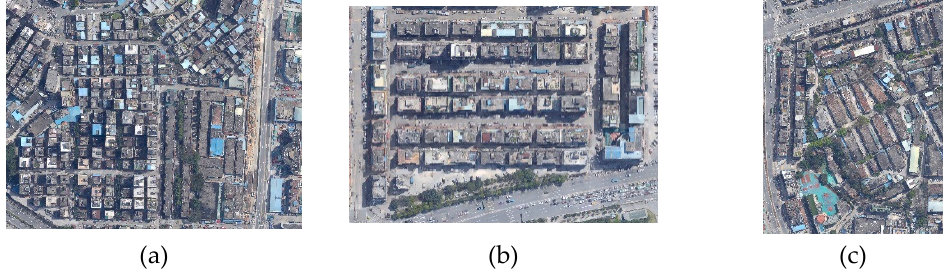
Figure 2. Expermential area of China. ( a ) region 1, ( b ) region 2, and ( c ) region 3 from drone images.